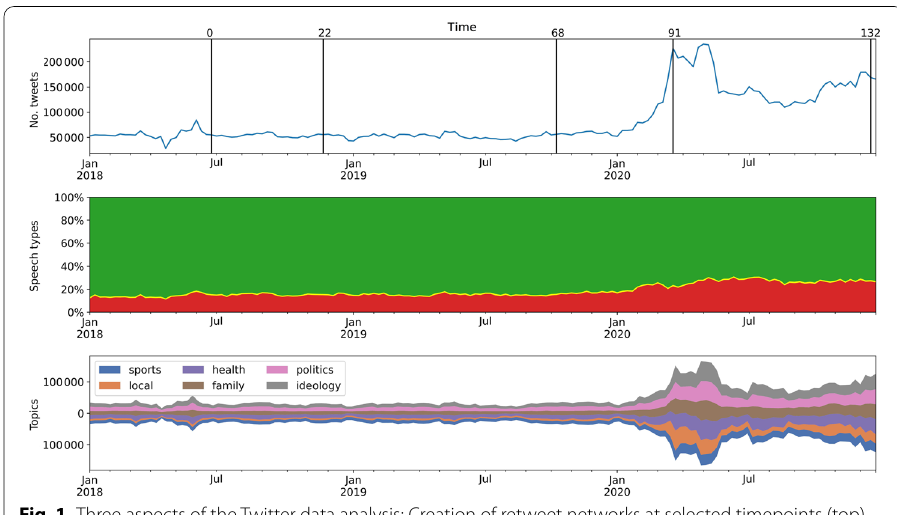
Fig. 1 Three aspects of the Twitter data analysis: Creation of retweet networks at selected timepoints (top), hate speech classification (middle), and topics detected (bottom). (Top) Weekly volume of the Slovenian Twitter data comprises original tweets and retweets collected over the period of 3 years. Vertical bars show five endpoints of automatically selected time windows for retweet networks construction, with weeks labeled as t = 0,22,68,91,132 . (Middle) Distribution of hate speech classes: fraction of acceptable tweets (green), inappropriate tweets (yellow, barely visible), and offensive tweets (red); violent tweets are not visible due to low volume. (Bottom) Distribution of the six detected